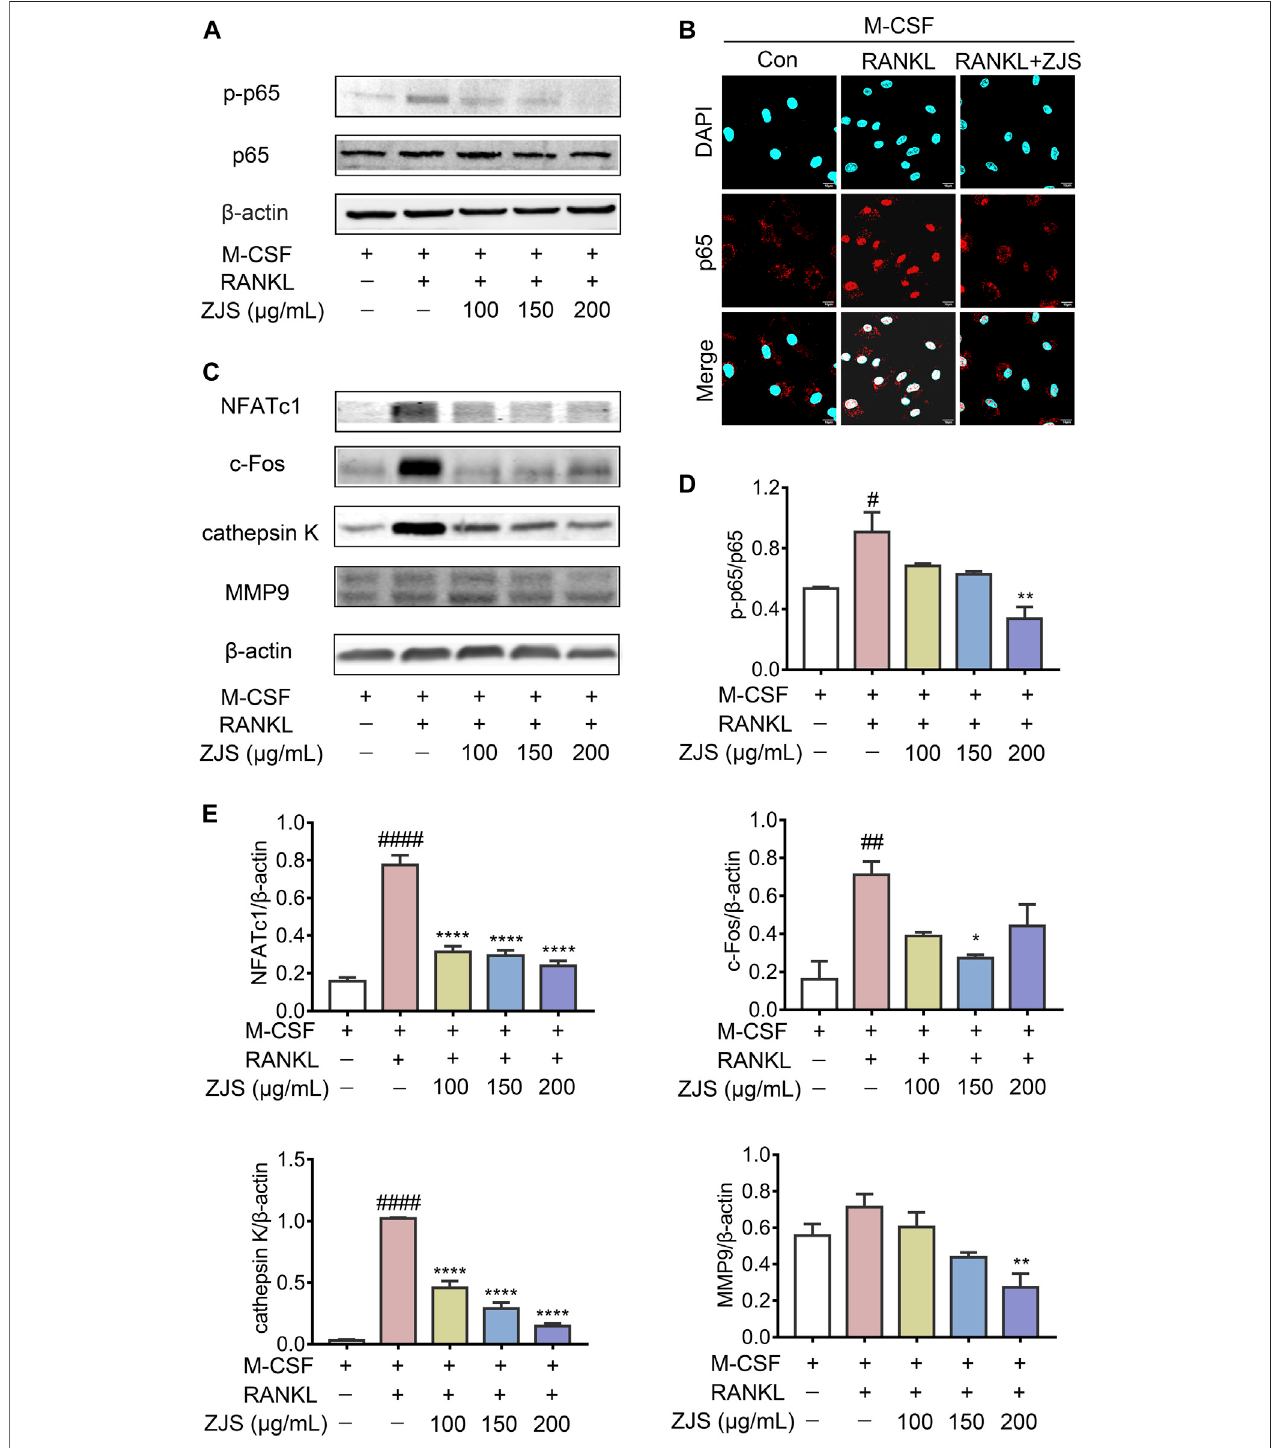
FIGURE 6 | ZJS suppressed the RANKL-induced NF- κ B signaling pathway. (A) Representative immunoblots of p65 and p-p65 in BMMs were performed by western blotting, β -actin was used as the internal reference protein. (B) Representative immuno fl uorescence images of p65 in the nucleus of BMMs in the indicated groups (scale bars (cid:1) 10 μ m). (C) Representative immunoblots of NFATc1, c-Fos, cathepsin K, and MMP9 in BMMs were performed by western blotting, β -actin was used as the internal reference protein. (D) Western blot analysis of p-p65 in BMMs in the indicated groups ( n (cid:1) 3). (E) Western blot analysis of NFATc1, c-Fos, cathepsin K, and MMP9 in BMMs in the indicated groups ( n (cid:1) 3). Values are presented as the mean ± SEM. # p < 0.05, ## p < 0.01, #### p < 0.001, compared with the RANKL-untreated group. * p < 0.05, **p < 0.01, ****p < 0.001, compared with the RANKL + ZJS-untreated group (One-way ANOVA test).